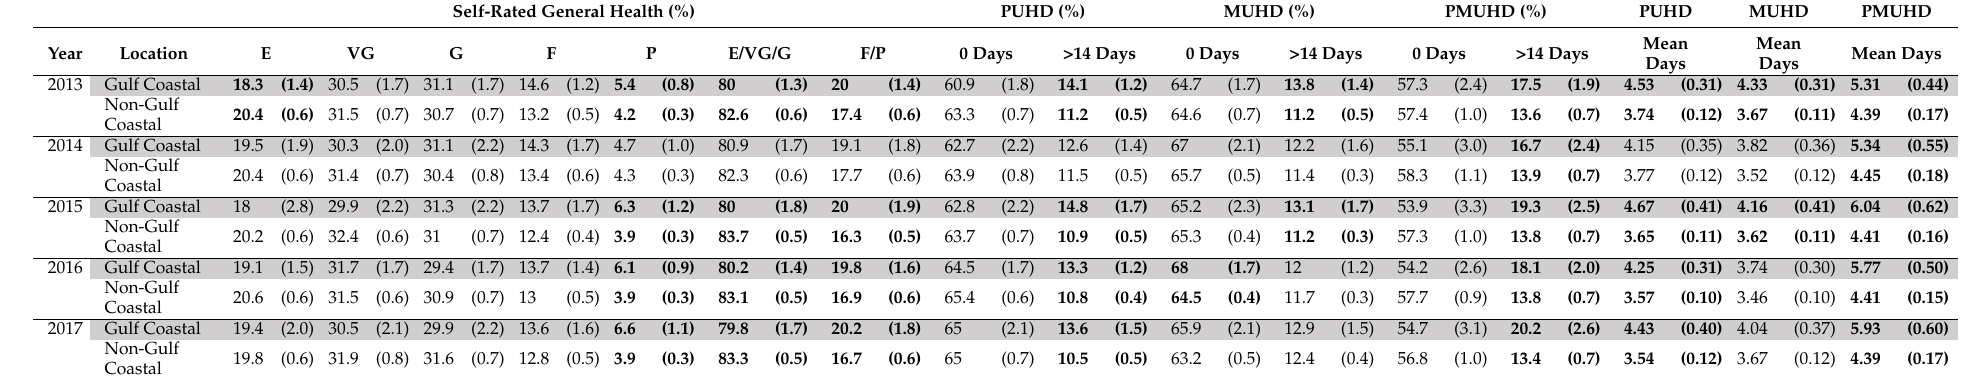
Table 5. Comparison of Gulf Coastal vs. Non-Gulf Coastal MMSAs: Mean self-rated general health and unhealthy days. (See table notes for explanation). Self-Rated General Health (%) PUHD (%) MUHD (%) PMUHD (%) PUHD MUHD